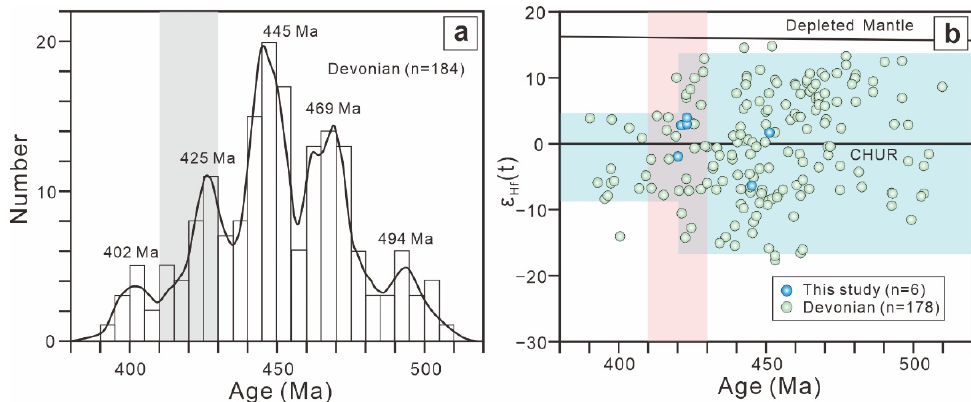
Figure 12. ( a ) Detrital zircon U–Pb age spectra of Phanerozoic detrital zircon grains from Devonian strata. ( b ) Detrital zircon ε Hf (t) values versus U–Pb age diagram of Phanerozoic detrital zircon grains from Devonian strata.